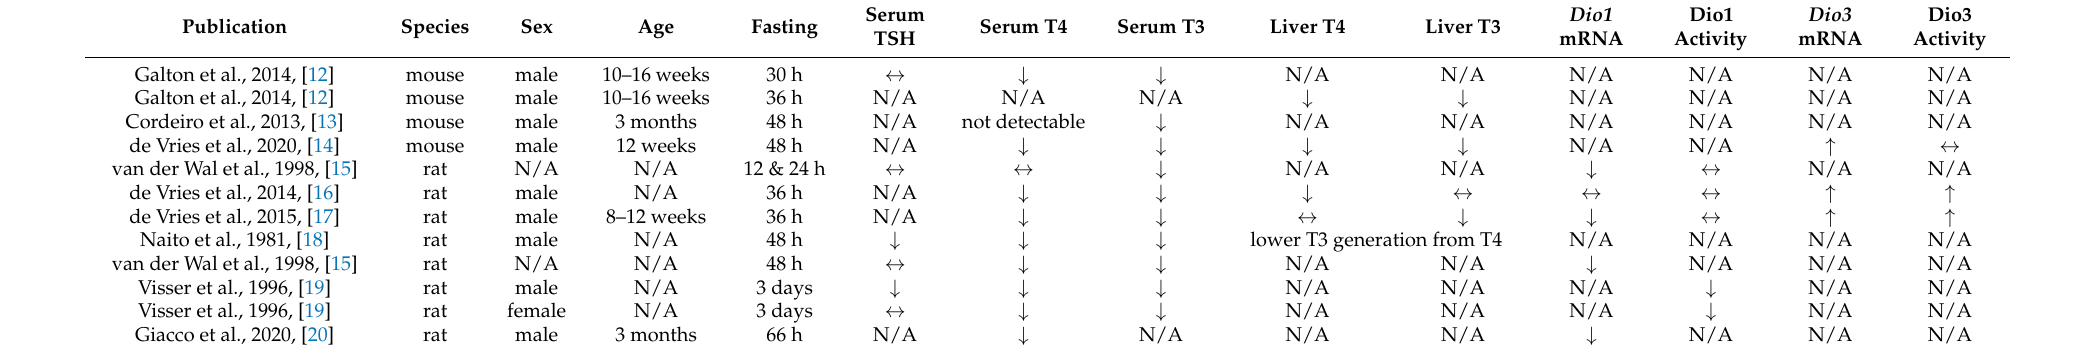
Table 1. Regulation of the TH system upon fasting. N/A: not available, ↔ : no change, ↓ : lower than control, ↑ : higher than control.